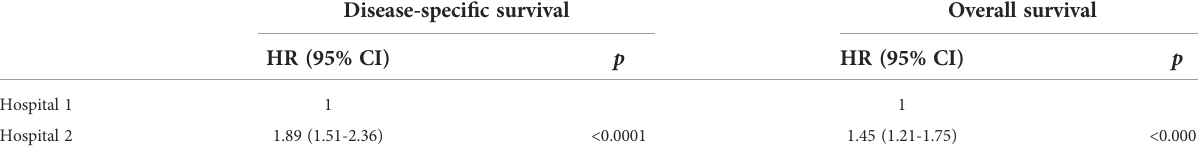
HR, hazard ratio; CI, con fi dence